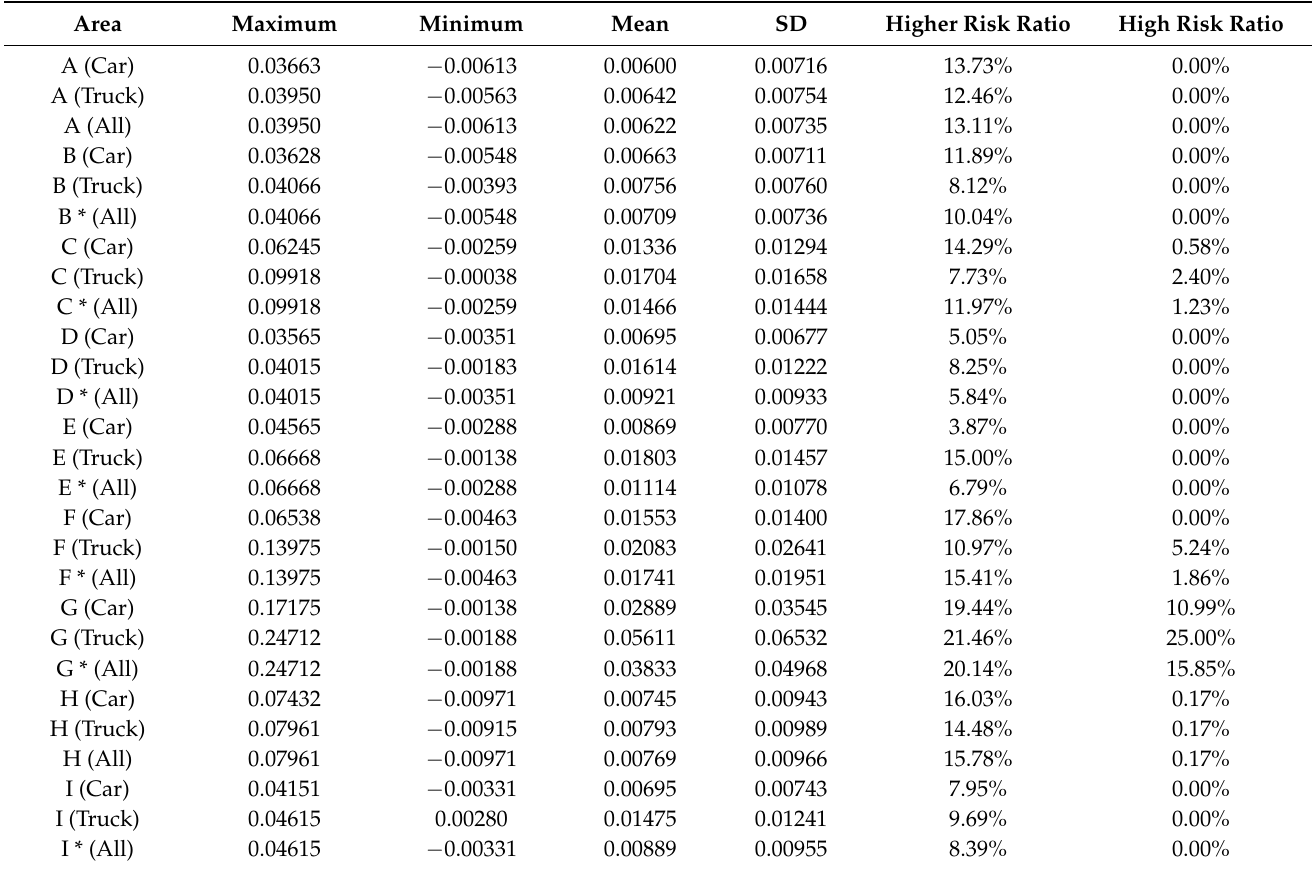
Table 6. Results of driving workload statistics for different areas and vehicles.